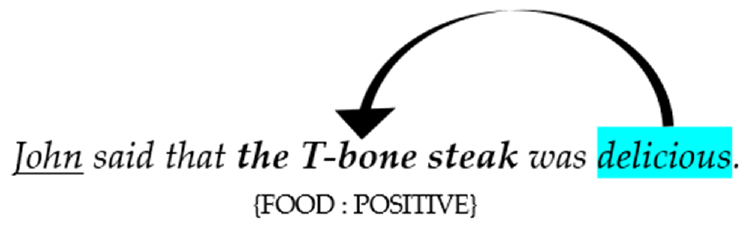
Figure 1. An example of ABSA on a restaurant review.